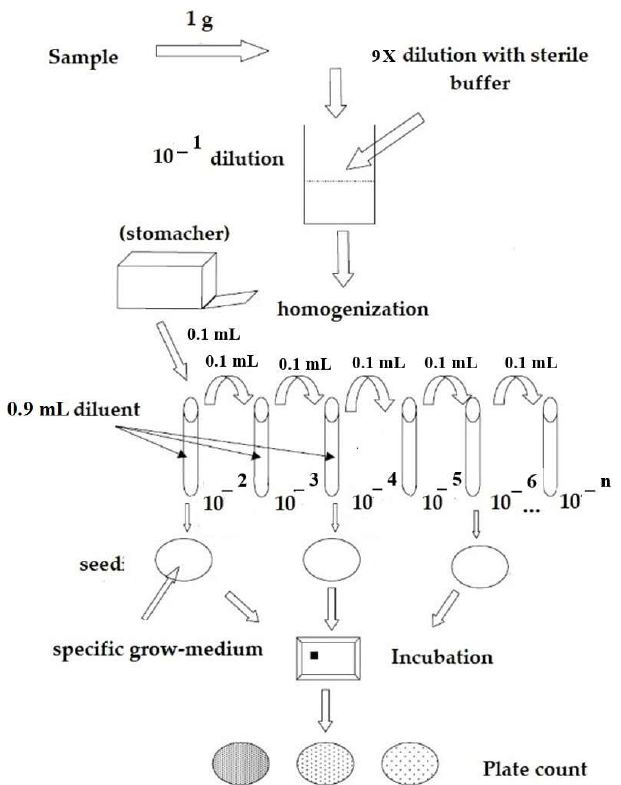
Figure 1. Representative flow chart of the operative workflow employed for plate count enumeration. Plate counts were performed, ensuring proportionality between the different dilutions tested. Results were expressed as colony-forming units per gram (CFU/g), in scientific notation, with 1 or 2 decimal numbers, considering the weighted average